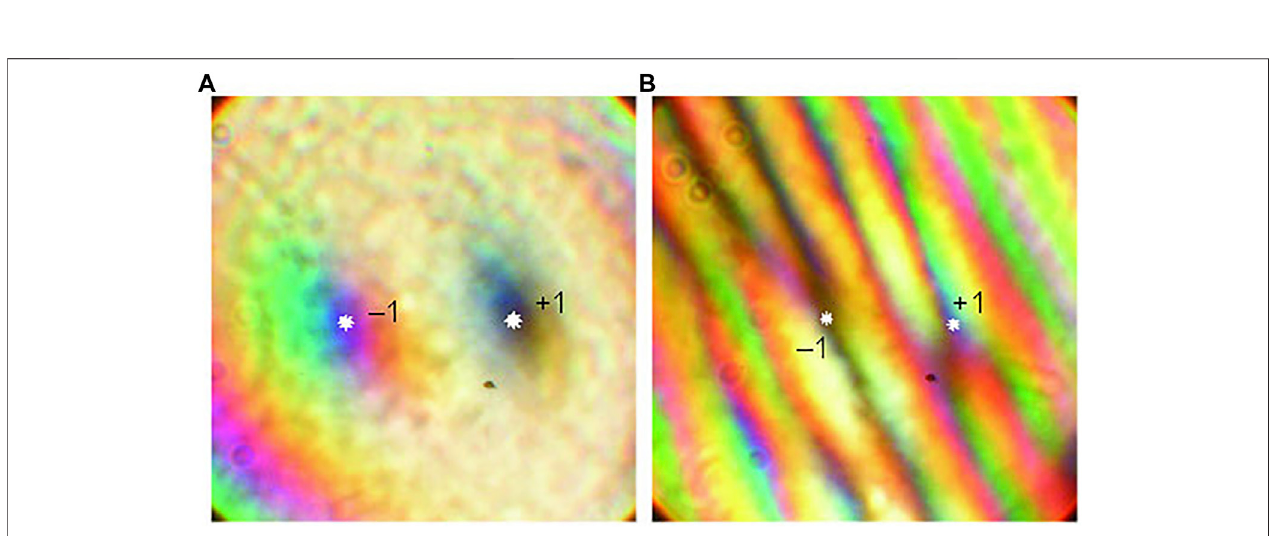
FIGURE 13 | Singularities obtained in a white-light beam passing a double-axial crystal placed between matched polarizer P1 and analyzer P2 ( Figure 12 ): (A) withoutreferencewave; (B) withareferencewave(interferencepattern).Thetopologicalchargesareindicatedofthetwosingularitieswithexactlocationsmarkedbythe